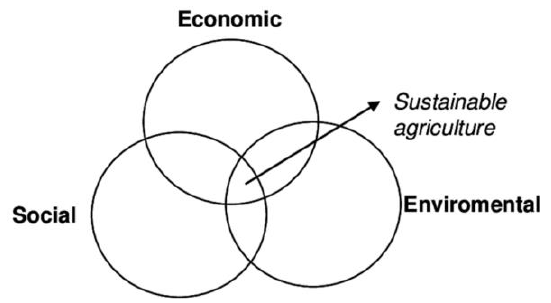
Figure 1 . Three dimensions to sustainability agriculture . Figure 1. Three dimensions to sustainability